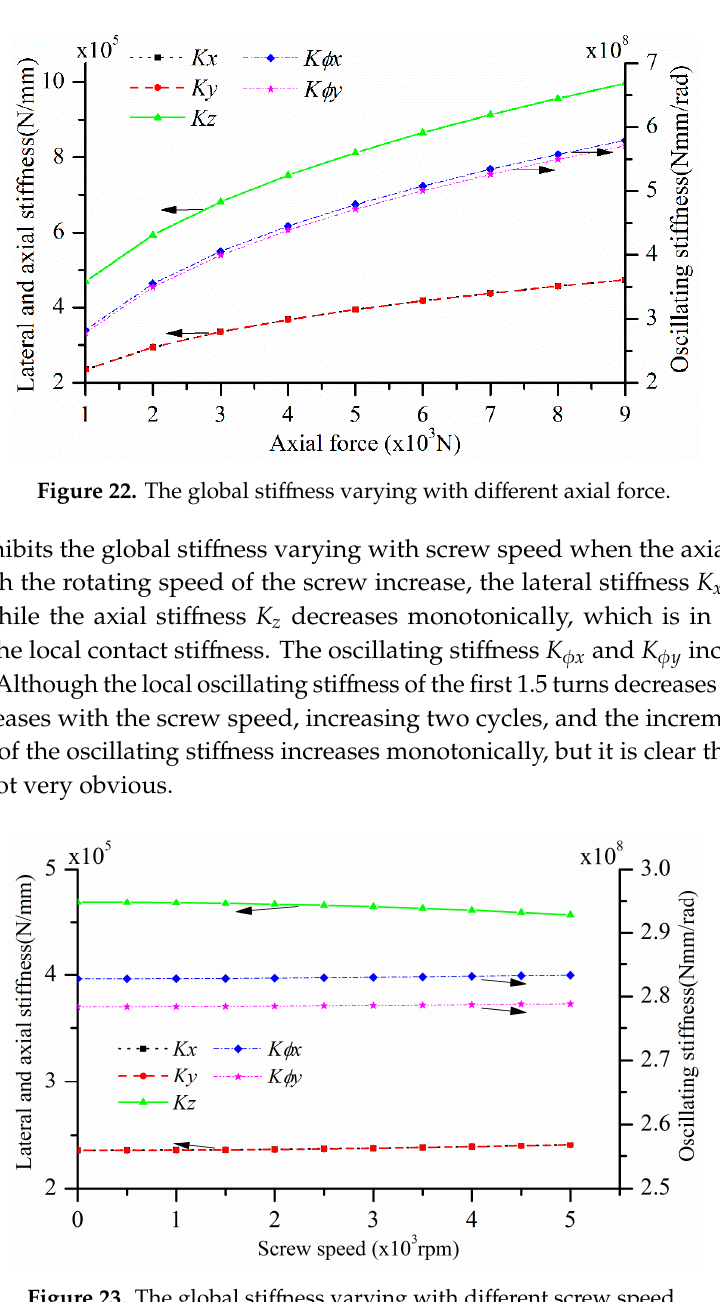
Figure 21. The difference value between the local oscillating stiffness of each contact pair at screw speeds of 5000 and 500 rpm.